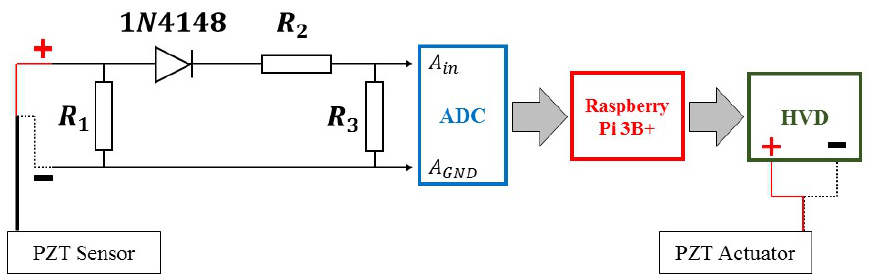
Figure 3. An illustration of the circuits used within the experimental set-up (an amended version of that shown in